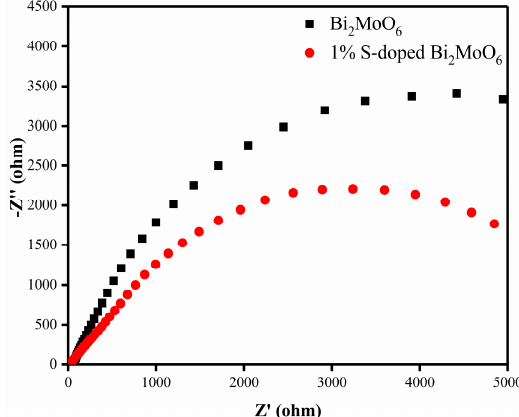
Figure 14. The Nyquist plots of Bi 2 MoO 6 and 1% S-doped Bi 2 MoO 6.